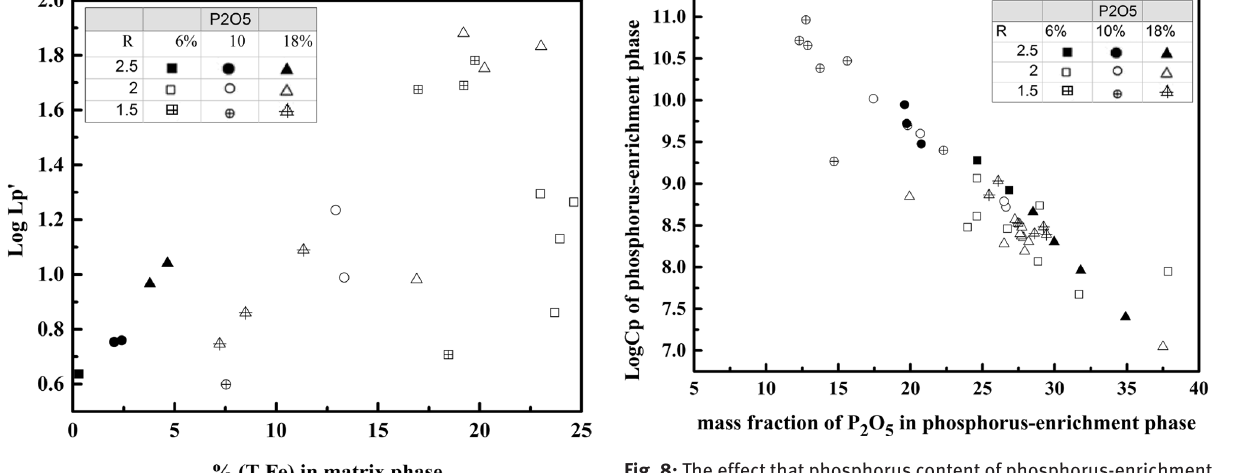
Fig. 8: The effect that phosphorus content of phosphorus-enrichment phase on phosphorus capacity in phosphorus-enrichment phase of